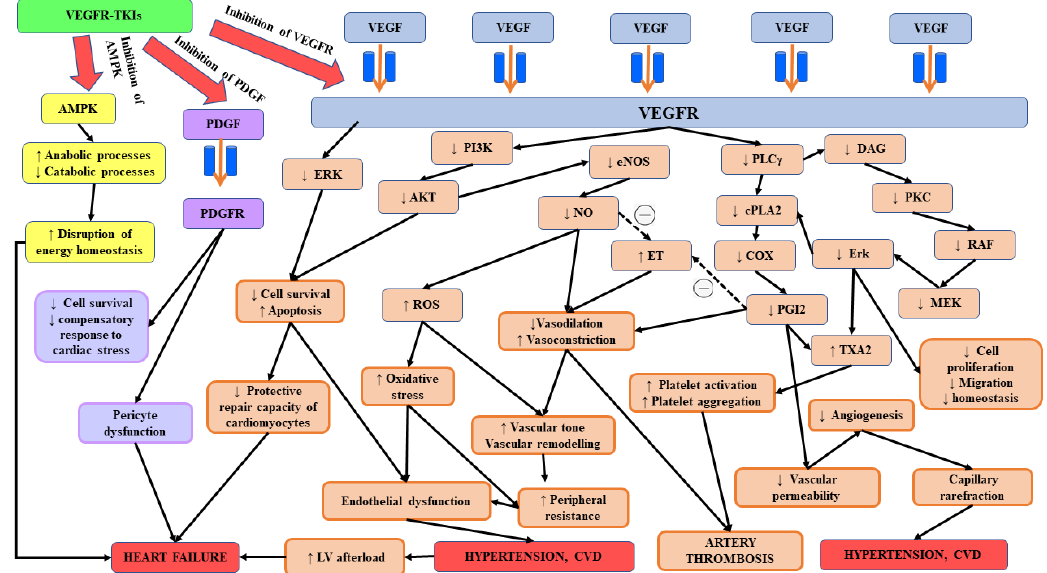
Figure 1. The results of VEGFR, AMPK and PDGFR inhibition leading to cardiotoxicity of VEGF signalling inhibition .